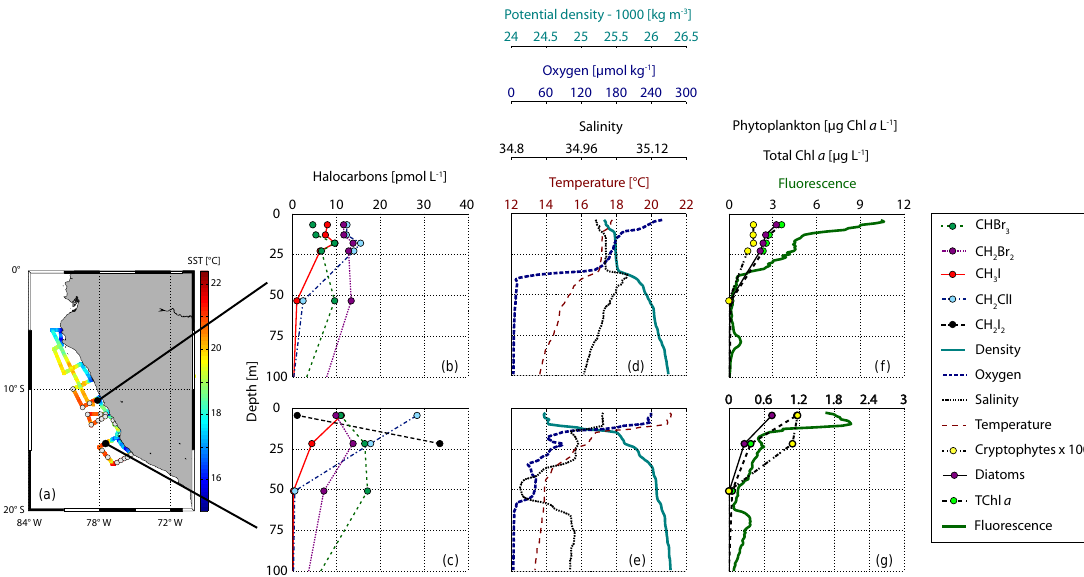
Figure 4. A cruise map including all CTD stations and SST is shown in panel (a) , while selected depth profiles of iodocarbons and bromo- carbons can be seen in panels (b–c) , together with ambient parameters such as potential density (cyan), oxygen (dark blue), salinity (black) and temperature (dark red) in panels (d–e) and phytoplankton groups (cryptophytes and diatoms), total chlorophyll a and fluorescence in panels (f–g) . CH 2 I 2 was undetectable at the first station (see also consistence with surface data). The data can be accessed at PANGAEA (Hepach et al.,